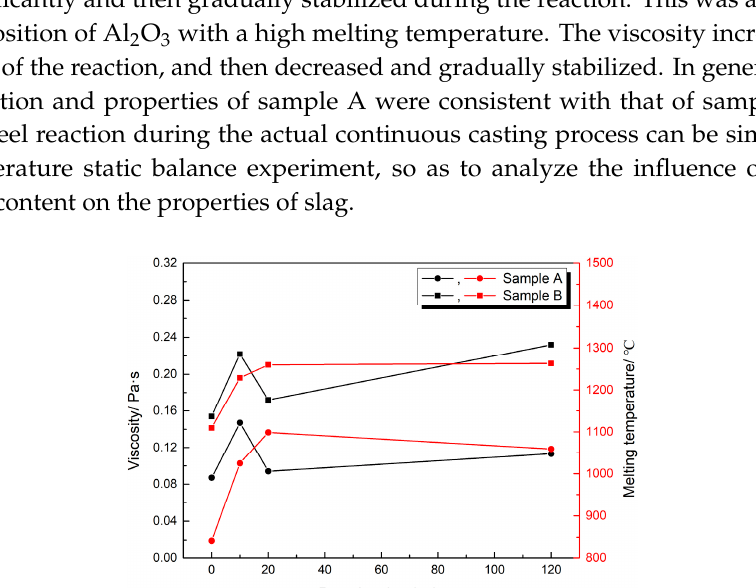
Figure 3. Variation of viscosity and melting temperature for slag sample A and B.